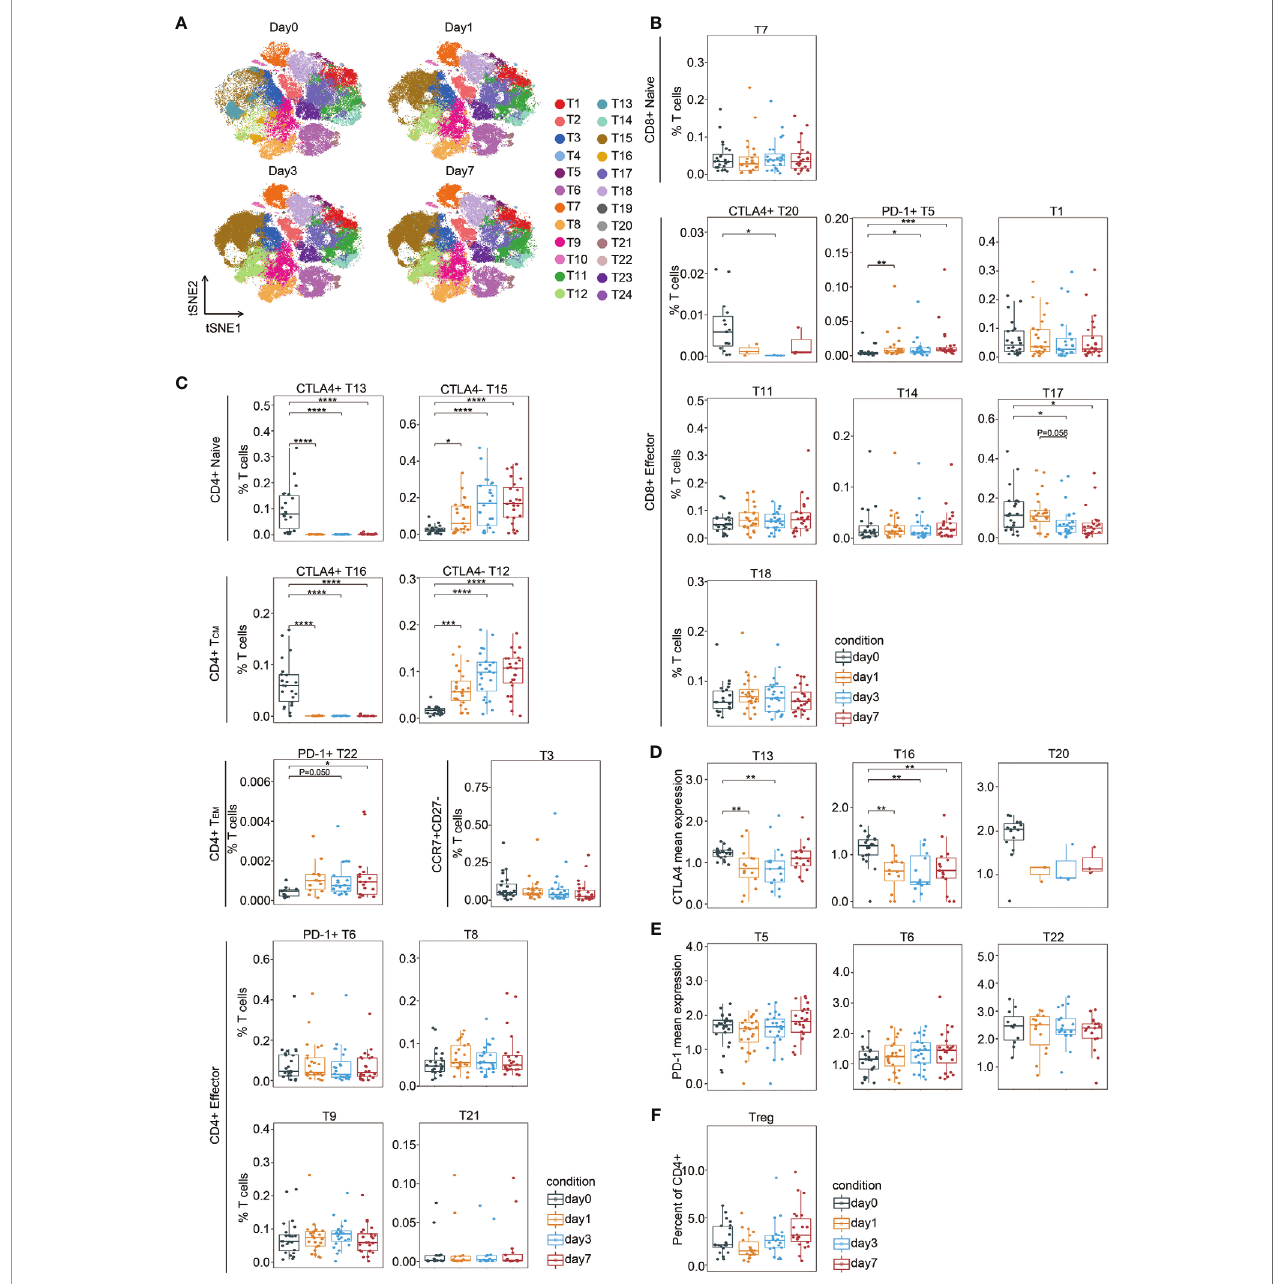
FIGURE 3 | T cell fl uctuation during perioperative period. (A) FIt-SNE plots highlighting the distribution of T cells at different time points. (B, C) Boxplots showing the frequencies of the CD8(+) T cell clusters (B) and the CD4(+) T cell clusters (C) during the perioperative period. (D, E) Boxplots showing the mean expression levels of CTLA-4 (D) and PD-1 (E) in T cells during the perioperative period. (F) Boxplots showing the frequencies of Treg cells during the perioperative period. *p < 0.05, **p < 0.01, ***p < 0.001, ****p < 0.0001 by Krustal-Wallis analysis with post-hoc Dunn test. P-value adjusted with the Benjamini-Hochberg